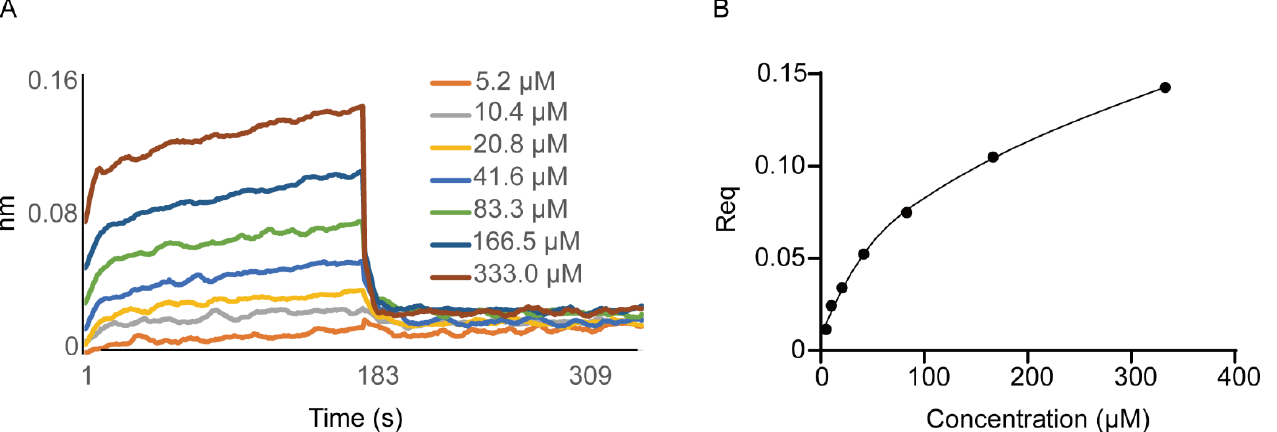
Figure 9. Kinetic analysis of compound QW12 against STAT3. ( A ) A BLI assay was performed on SARTORIUS Octet R8 using SSA biosensors. The fitting of the kinetic curve and the calculation of the KD were performed with SARTORIUS Octet Evaluation software. ( B ) The saturation binding curve derived from the steady-state values of the sensorgram curves shown in panel A. Req values were derived by calculating the average of data points collected during the 0 to 120 s window of the association step. Values are presented as means ± SDs of three independent experiments. n/s is not significant, * p < 0.1, ** p < 0.01, *** p < 0.001.